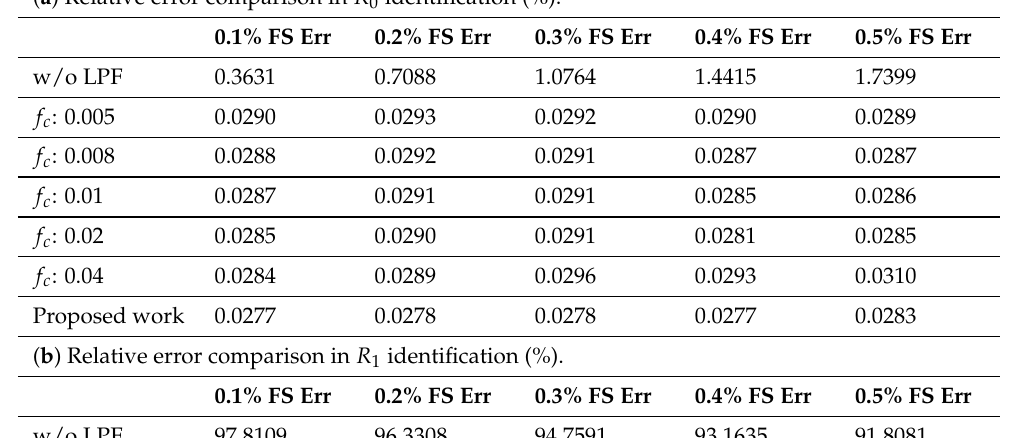
Table 2. Parameter identification performance comparison in cases of various scales of measurement noises using multiple cutoff frequency design.